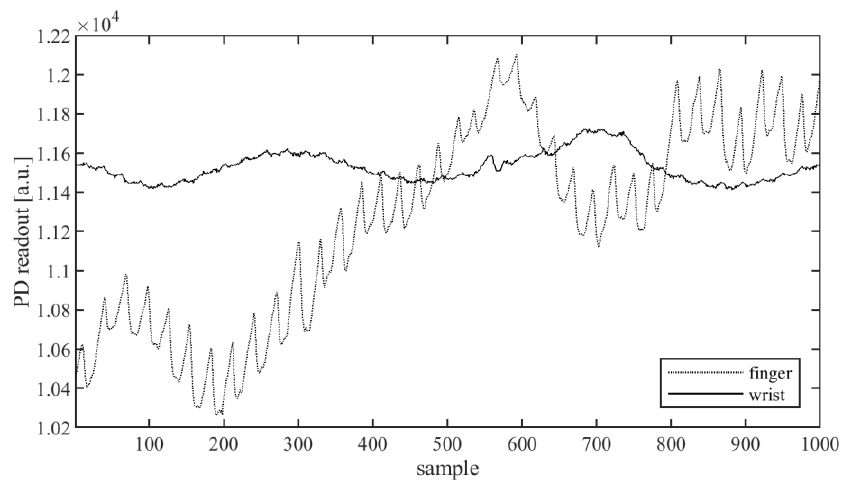
Figure 1. Photodetector ( PD) waveforms: raw signals obtained from photoplethysmography (PPG) sensor in reflective configuration placed on the index tip (dotted line) and on the wrist (continuous line).